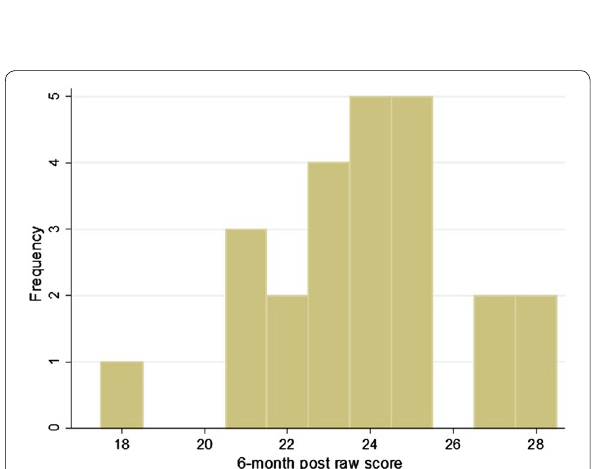
Fig. 1 Sample test question of clinical application of bedside ultra- sound